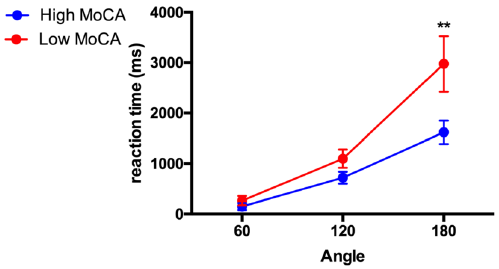
Figure 4. Reaction time on the Mental Rotation of hands relative to no rotation (0°) for patients with (red) and without cognitive impairment